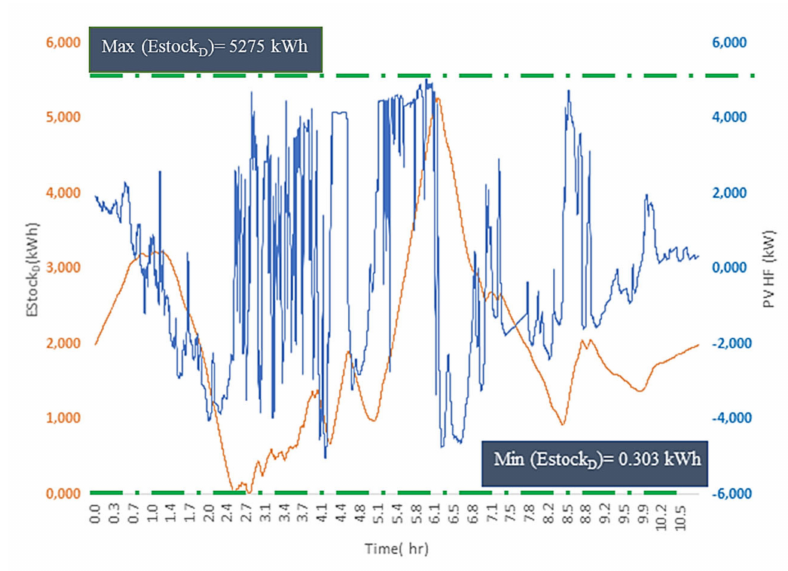
Figure 25. Evolution E stock and PVHF residue profile of 28 August